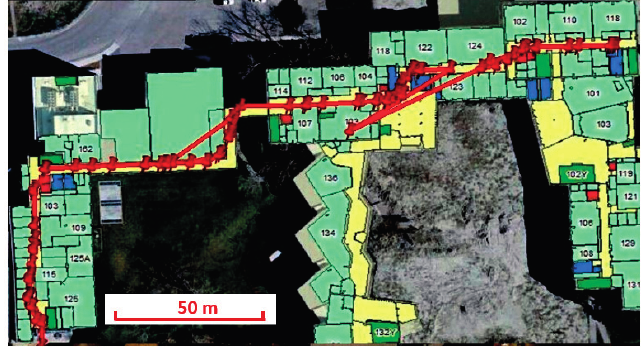
Figure 17. WiFi fingerprinting result at ENB.